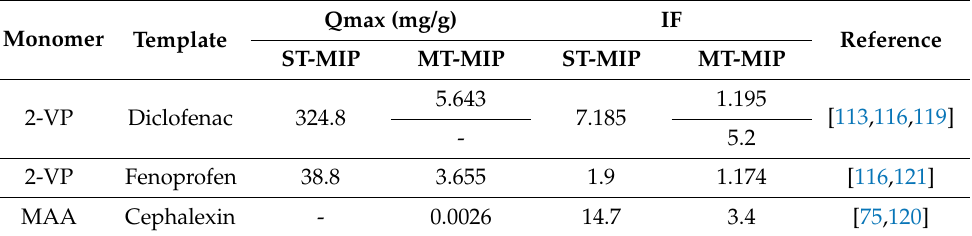
Table 4. Comparison of single-template and multi-template molecularly imprinted polymers gener- ated using drug